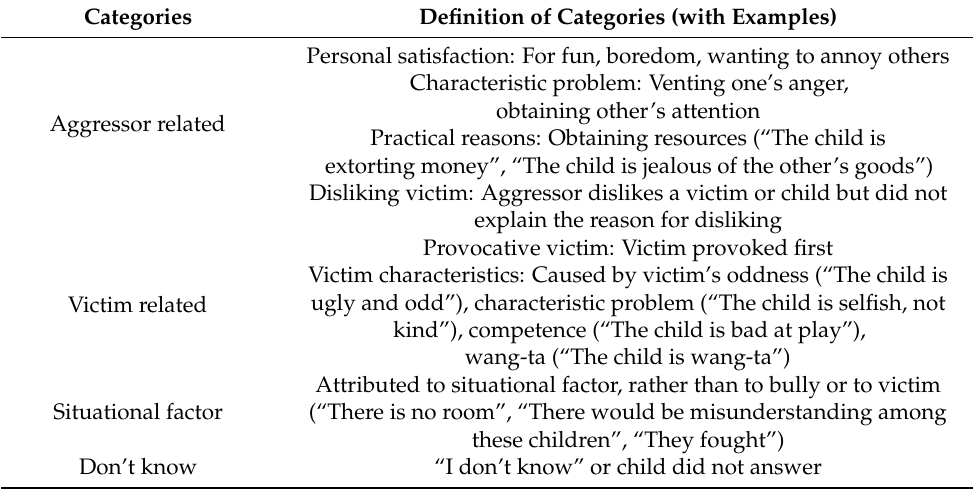
Table 2. Categories for causal attribution (Why do you think this